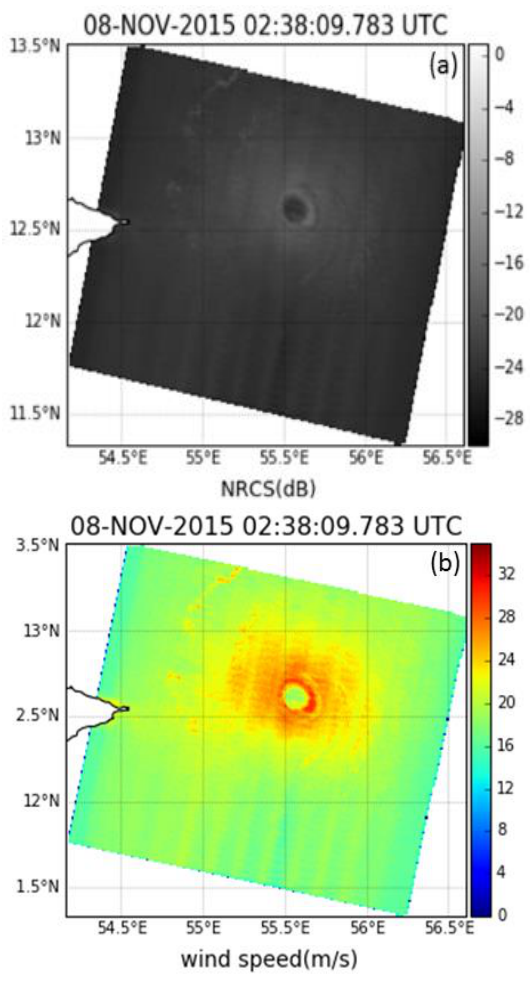
Figure 1. RISAT-1 retrieved NRCS (a) and wind speed